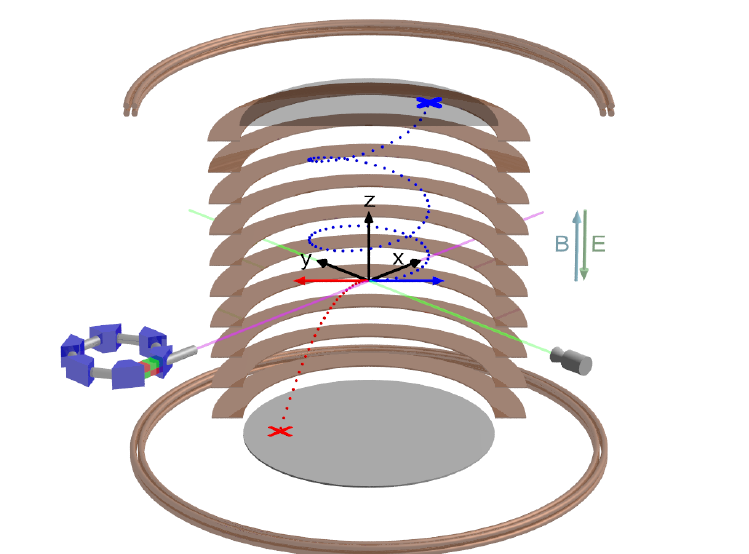
Figure 1. Concept of cold target recoil ion momentum spectroscopy (COLTRIMS). A supersonic jet (green) of a target gas is crossed with synchrotron light (violet) at a right angle. A homogeneous electric field E , generated by a spectrometer (copper plates), and a homogeneous magnetic field B , created by a Helmholtz pair (copper tubes), guide the charged reaction fragments (red trajectory: ion, blue trajectory: electron) towards time- and position-sensitive detectors. The initial three-dimensional momentum vector of each reaction fragment (blue and red arrows) was calculated from the time-of- flight and the position of impact on the detectors (marked with a blue and a red